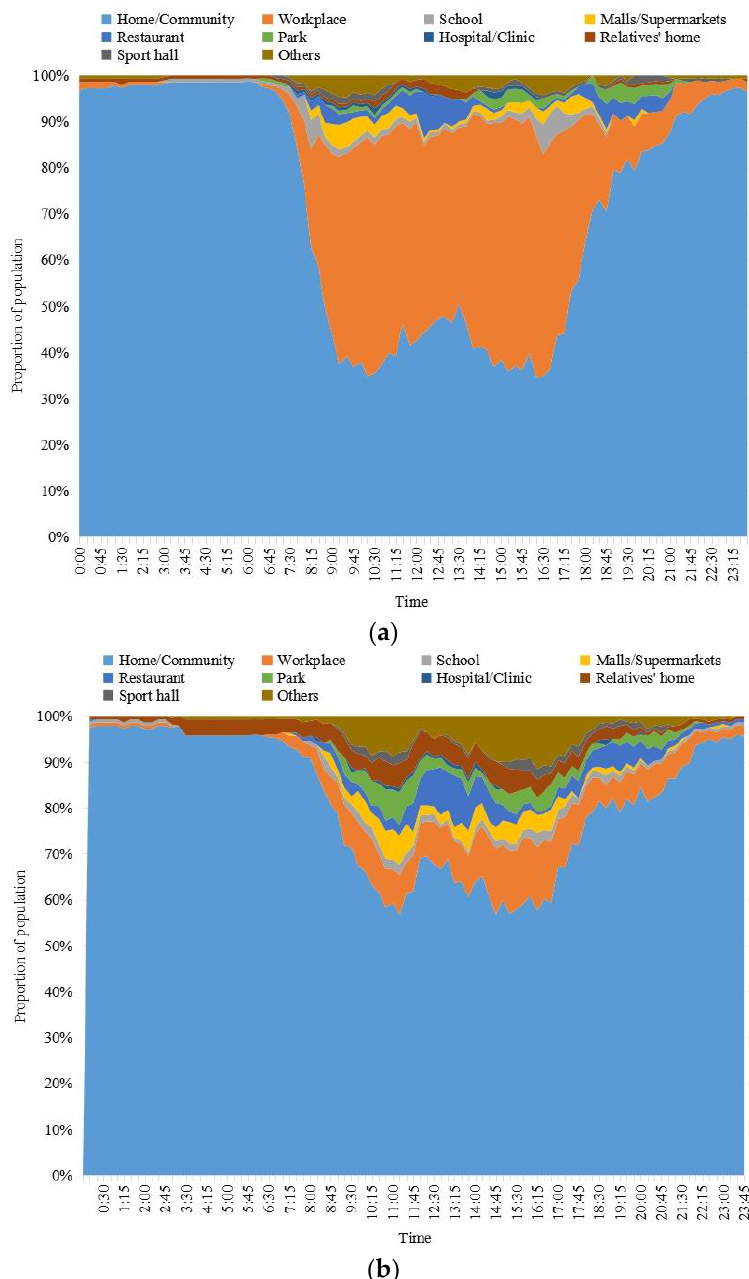
Figure 2. The relationship between activity location and time of workdays and weekends. ( a ) Work- day; ( b ) weekend.